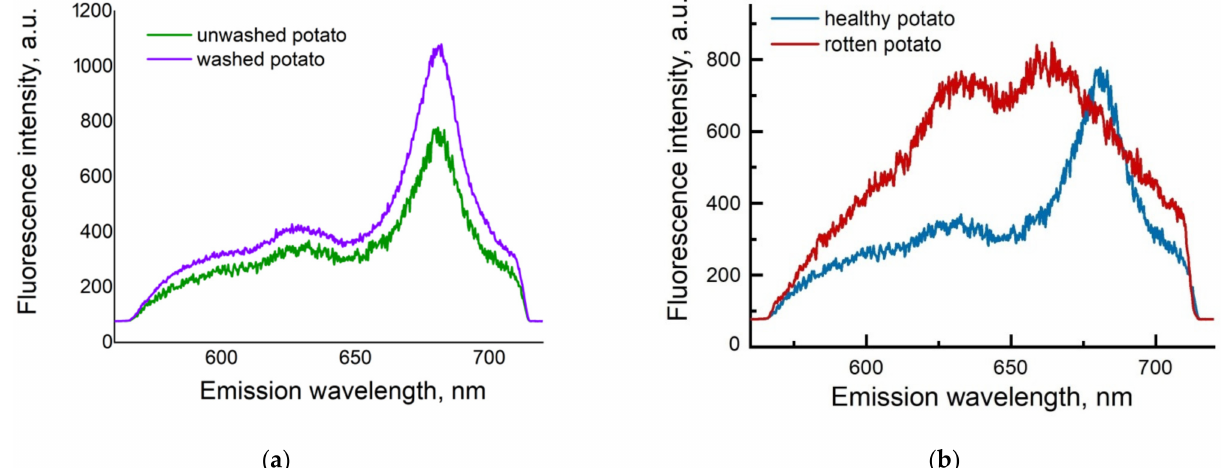
Figure 10. ( a ) Pulsed fluorescence spectra of surface of “Udacha” (healthy) dirty (green) and washed (violet) potato; ( b ) pulsed fluorescence spectra of surface of “Udacha” (conditionally healthy) (blue) and “Zhukovsky” (conditionally rotten) (red) dirty